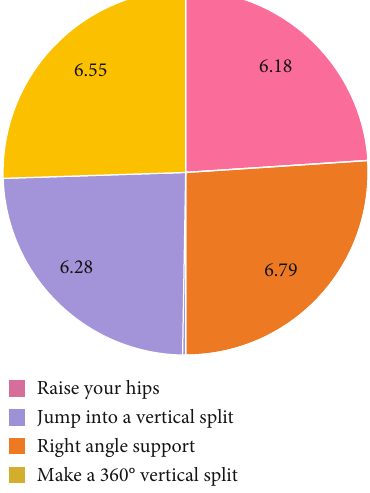
Figure 4: Statistics of di ffi culty movement test results in control group after